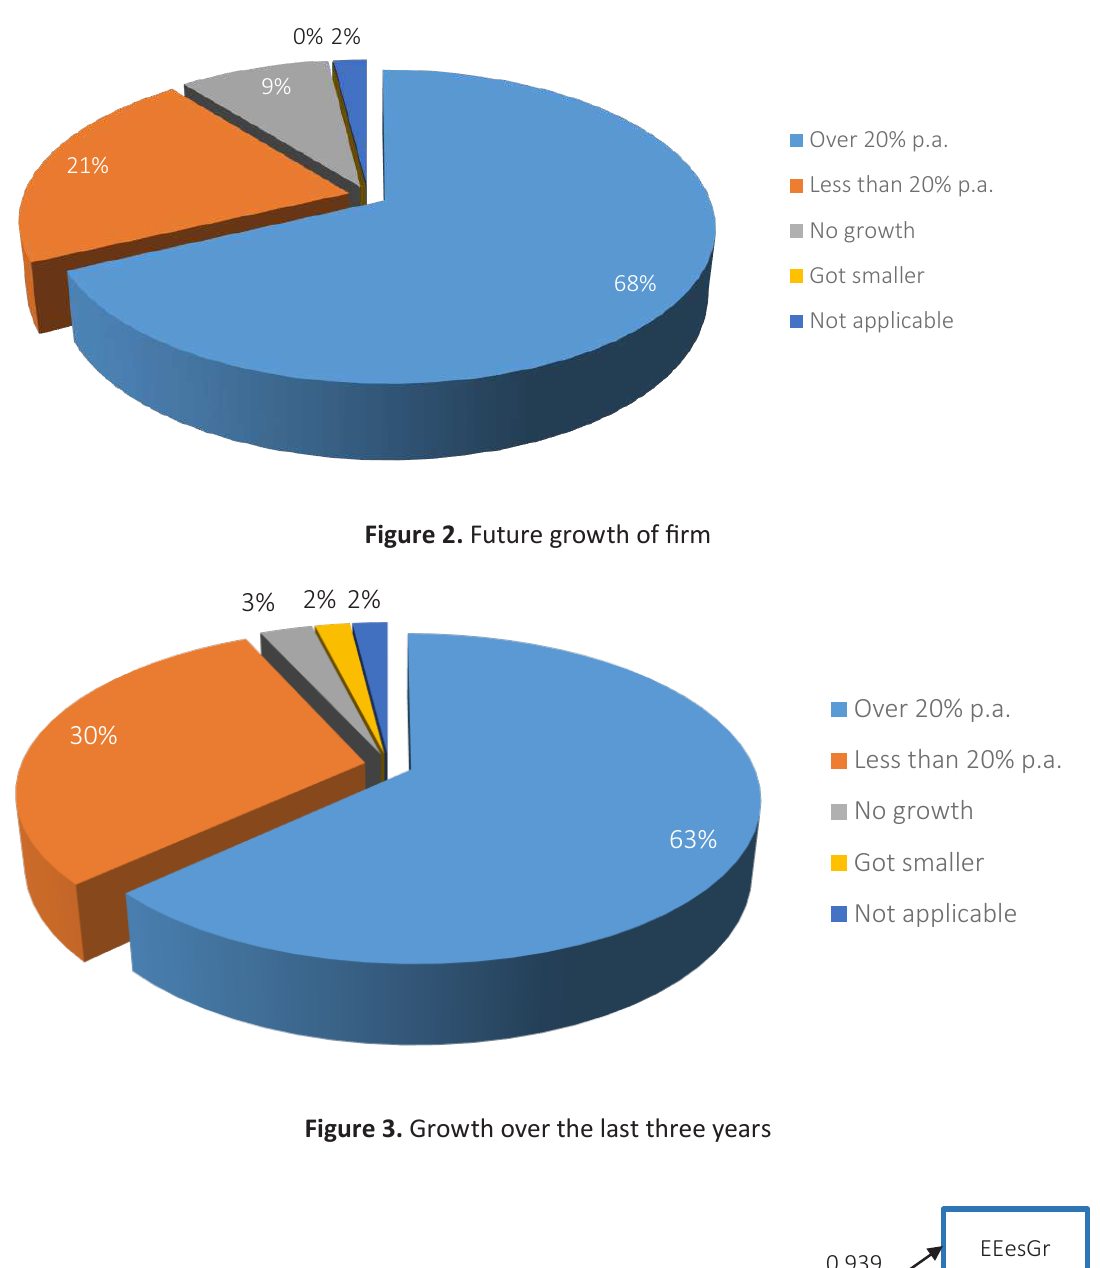
Figure 3. Growth over the last three years